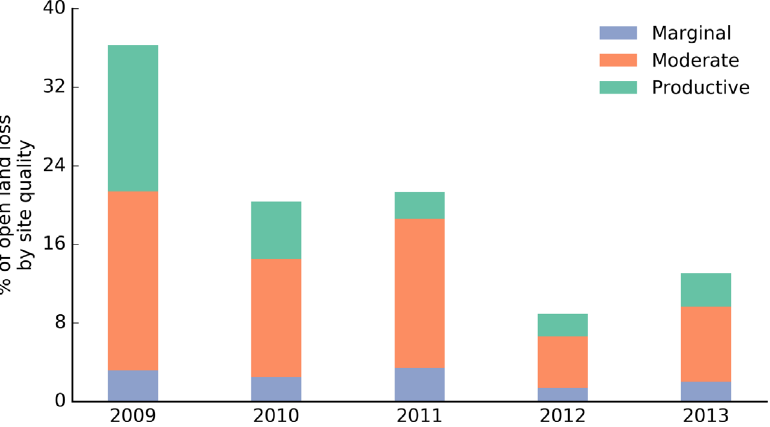
Fig 7. Percentage of open land loss within each site-quality class for each year starting from